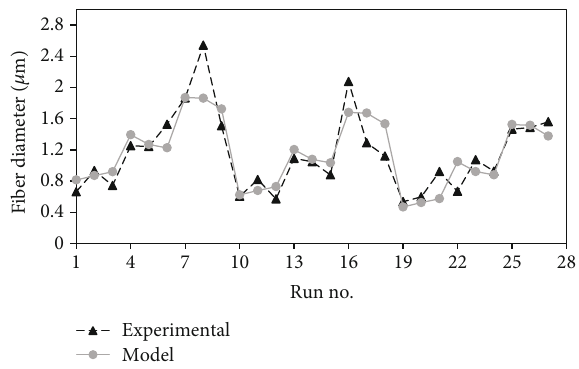
Figure 4: Mathematical model validation with experimental